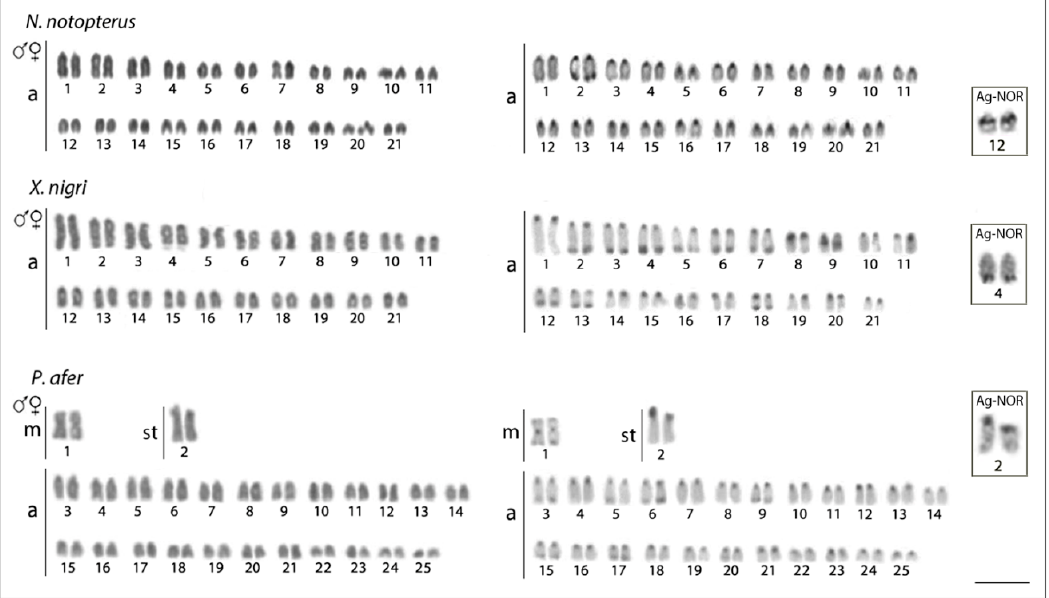
Figure 3. Karyotypes of Notopterus notopterus , X. nigri , and Papyrocranus afer analyzed after conventional Giemsa staining and C-banding procedures. The Ag-NOR pairs are highlighted in the boxes. Scale bar = 5 μ m.